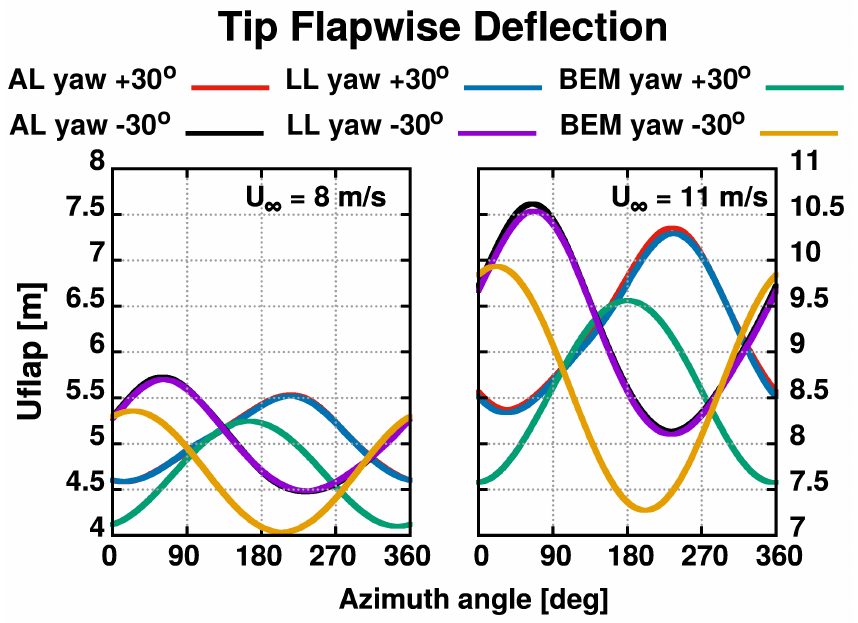
Figure 26. Out-of-plane deflection of blade tip at 30 ◦ yawed wind speed at 8 and 11